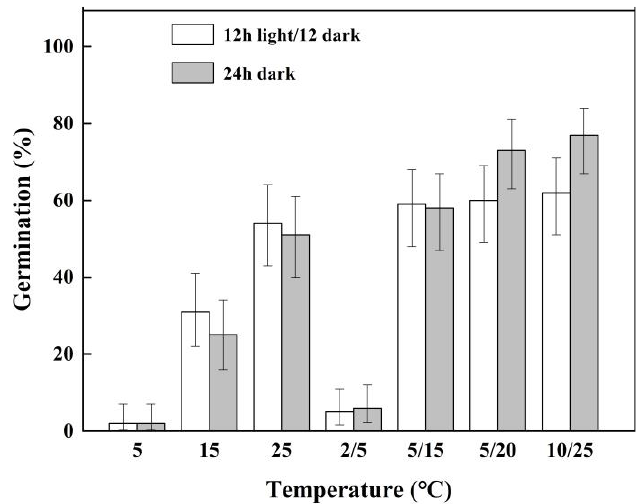
Figure 2. Germination percentage (±95% binomial confidence intervals) of P. kansuensis seeds incubated under different temperature and light conditions.